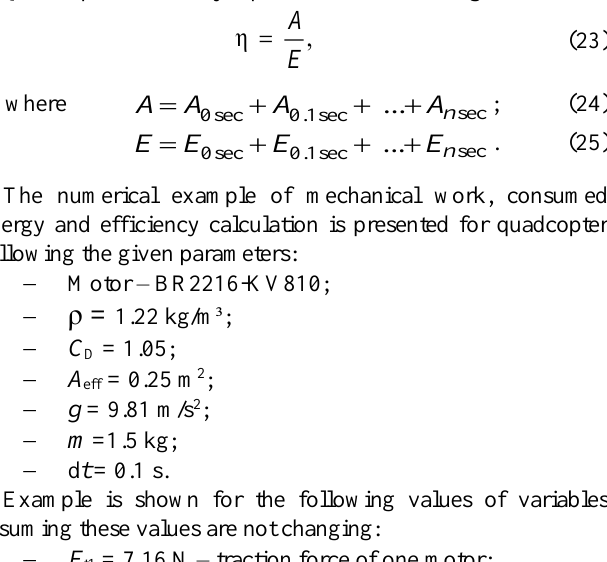
The experiment shows how the unified optimal algorithm performs the control of the UAV for the take-off